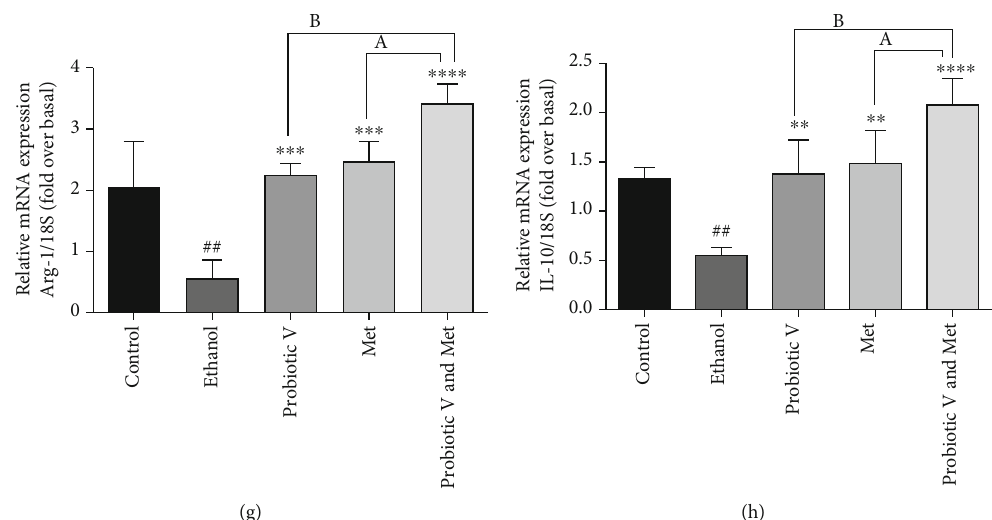
Figure 14: qRT-PCR analysis of (a) IL-6, (b) IL-12, (c) iNOS, (d) TLR-4, (e) TNF- α , (f) NOX-1, (g) Arginase-1, and (h) IL-10 genes from ethanol-exposed RAW 264.7 cells along with probiotic V and Met alone or together as probiotic V and Met combination for 48h. The gene expression levels were calculated after stabilizing against 18S rRNA in every sample and are represented as relative mRNA expression units. Values represent the mean ± SD of three individual experiments. Statistical signi fi cance was assessed by one-way ANOVA followed by Tukey post hoc test. Statistical analysis: ## p < 0 : 01 , ### p < 0 : 001 , and #### p < 0 : 0001 compared with control group; ∗ p < 0 : 05 , ∗∗ p < 0 : 01 , ∗∗∗ p < 0 : 001 , and ∗∗∗∗ p < 0 : 0001 compared with ethanol group; A,B p < 0 : 05 , AA,BB p < 0 : 01 , and AAA,BBB p < 0 : 001 compared with probiotic V and Met combinatorial